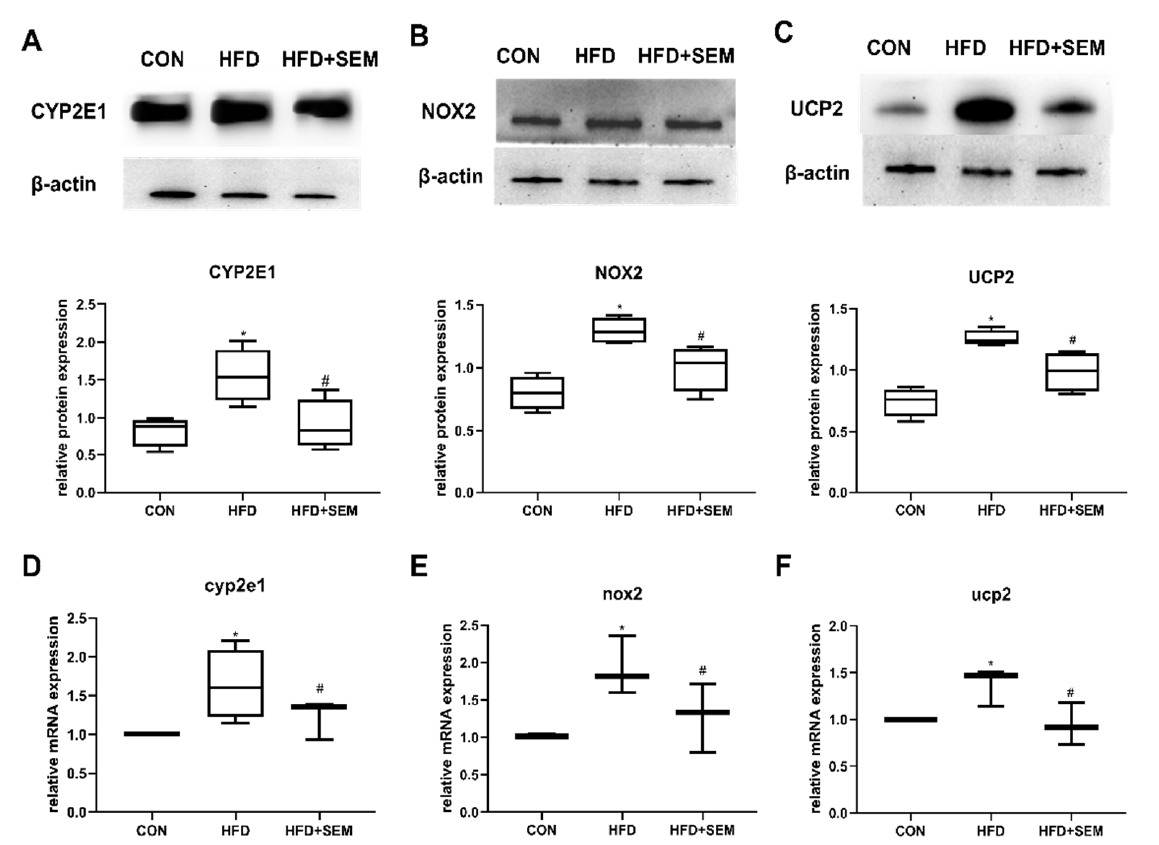
Figure 4. SEM treatment prevents HFD-induced hepatic steatosis by inhibiting protein and mRNA expression of enzymes involved in oxidative stress generation in the liver. Effects of HFD and HFD + SEM on the hepatic protein expression of ( A ) CYP2E1, ( B ) NOX2, ( C ) UCP2, and on hepatic relative mRNA expression of ( D ) cyp2e1 , ( E ) nox2 , ( F ) ucp2 . The analysis of the relative intensities quantified by densitometry on western blots is presented in the lower panels. Data are presented as min to max in box-and-whisker diagrams and were analyzed with one-way ANOVA; * marks significant differences compared to the control group ( p ≤ 0.05); # marks significant differences between the HFD group and the HFD + SEM group ( p ≤ 0.05).